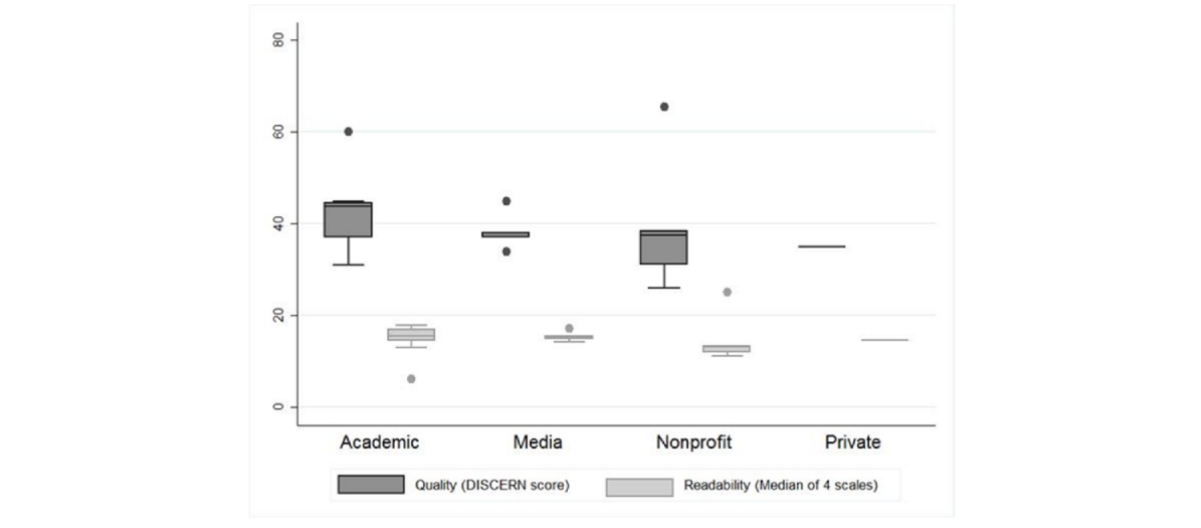
Figure 1. Box plot comparing website quality (DISCERN score, range 16-80 points) and readability (average of 4 instruments, range 5-19 points) by publisher affiliation. Lines represent upper and lower quartiles and dots are outliers.